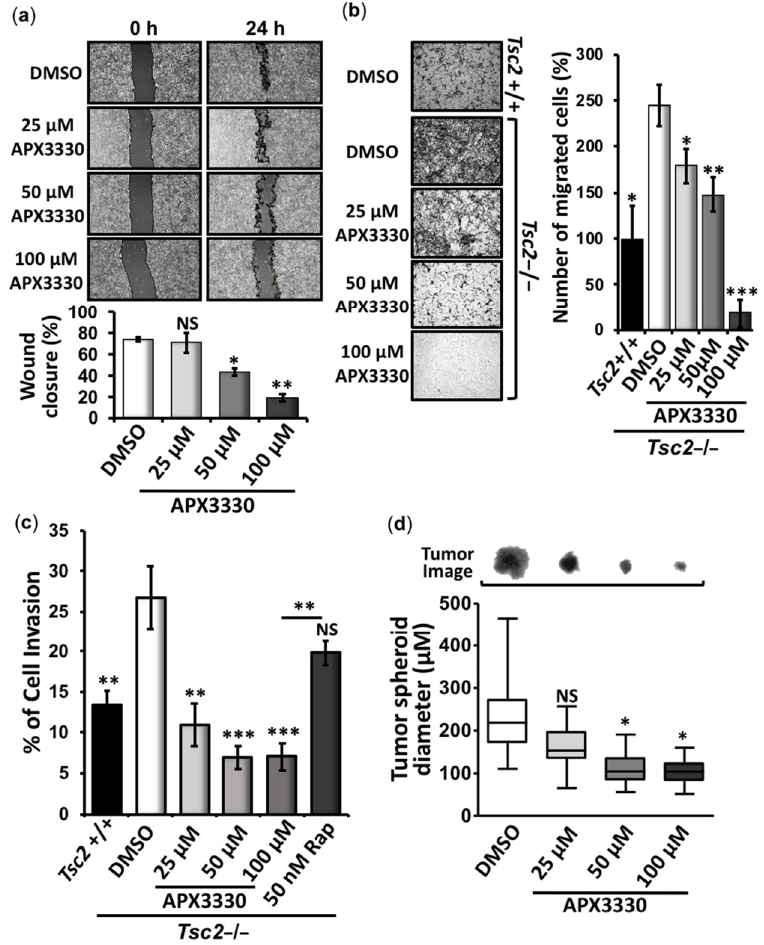
Figure 4. APX3330 inhibits the cell migration/invasion and tumor formation of Tsc2 − / − MEFs. Tsc2 − / − MEFs were subjected to ( a ) wound scratch assays ( n = 3), ( b ) cell migration ( n = 3), ( c ) cell invasion ( n = 4), and ( d ) in vitro tumor formation assays (30 tumors analyzed within three biological repeats) in the presence or absence of either DMSO or APX3330 (25, 50, and 100 µ M), where indicated. Tsc2 +/+ MEFs were used as controls in both the cell migration and cell invasion assays. Error bars represent SDs (SEMs for ( d )); * p < 0.05, ** p < 0.01, *** p < 0.001 when compared to DMSO.